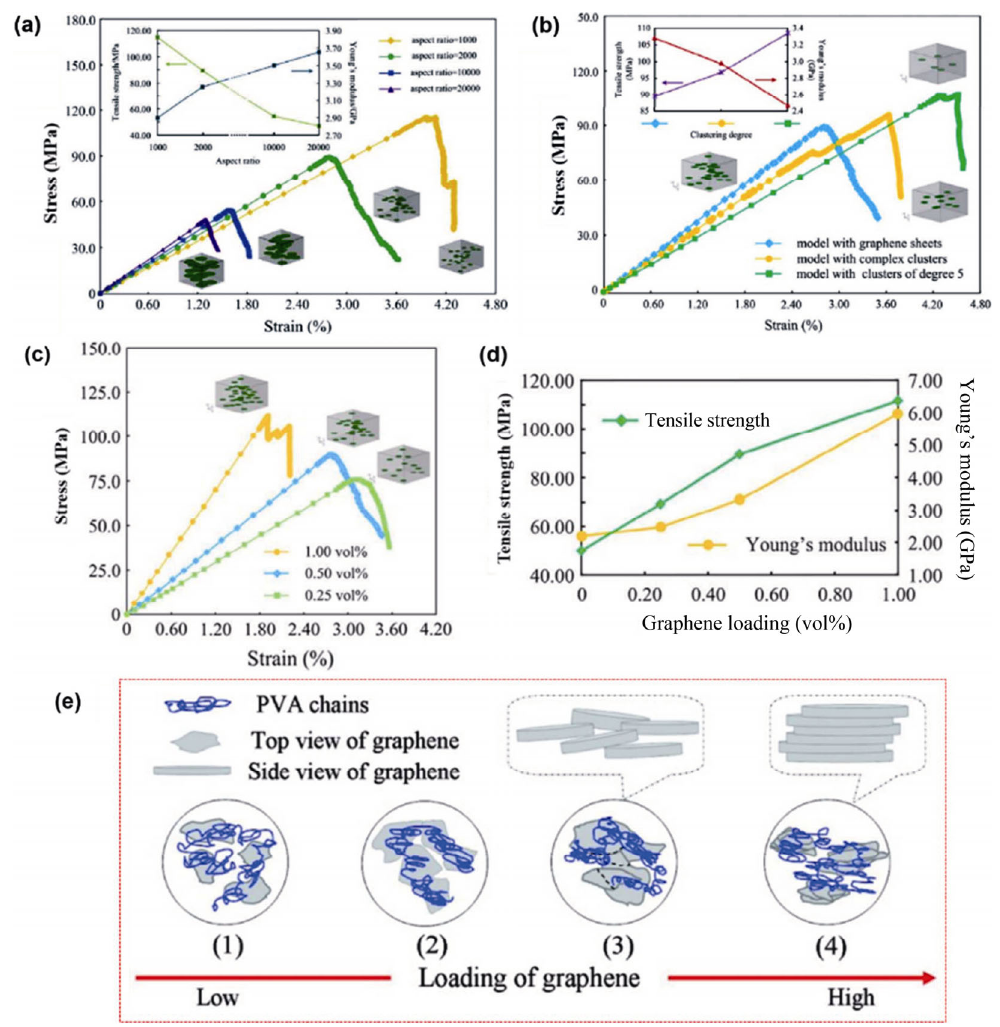
Fig. 15 Effect of (a) aspect ratio, (b) dispersion, and (c, d) volume content of graphene on the strain–stress curves of nanocomposites. Reproduced with permission from Ref. [63], © Elsevier B.V. 2014. (e) Schematic of the effect of volume content on the microstructure. Reproduced with permission from Ref. [55], © American Chemical Society